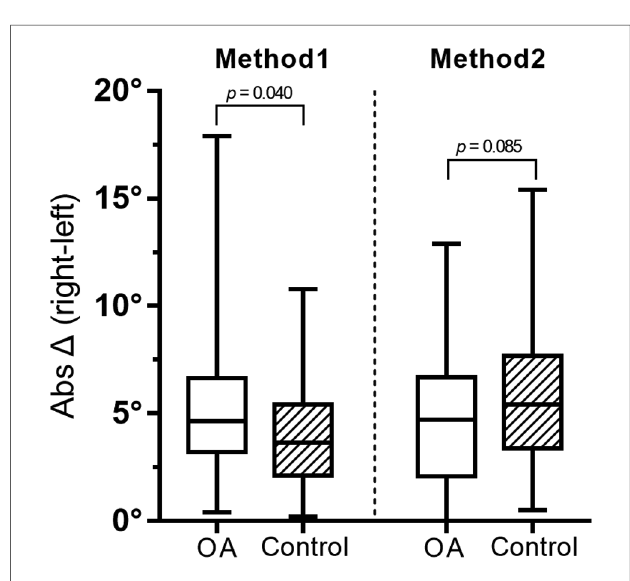
FIGURE 3 Overall results of methods 1 and 2 by a box-whisker plot. OA,